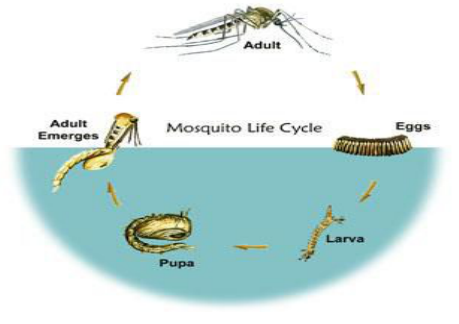
Figure 1. Mosquito Life Cycle